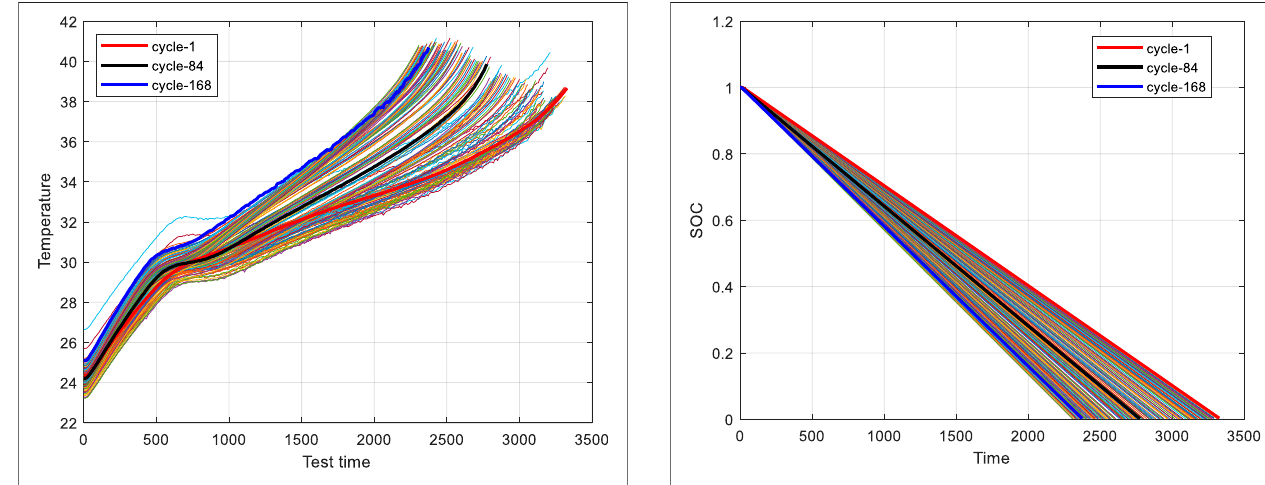
FIGURE 7 | Discharge temperature diagram of battery #2.